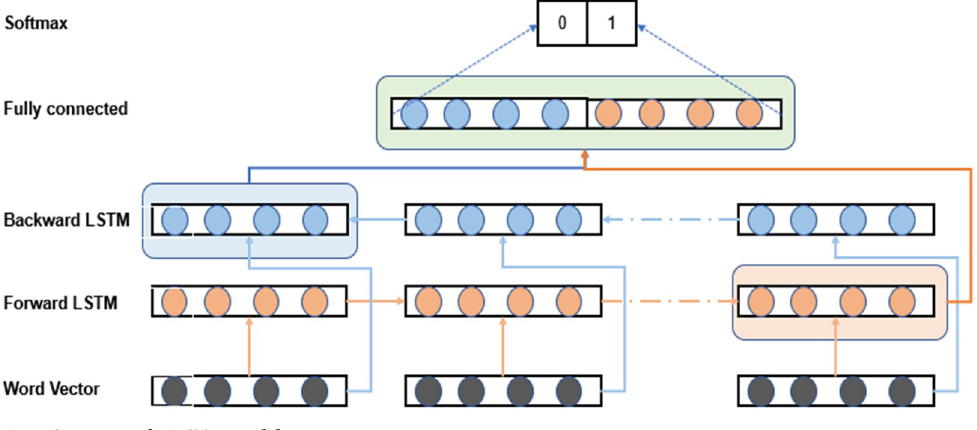
Fig 2. Structure of BiLSTM